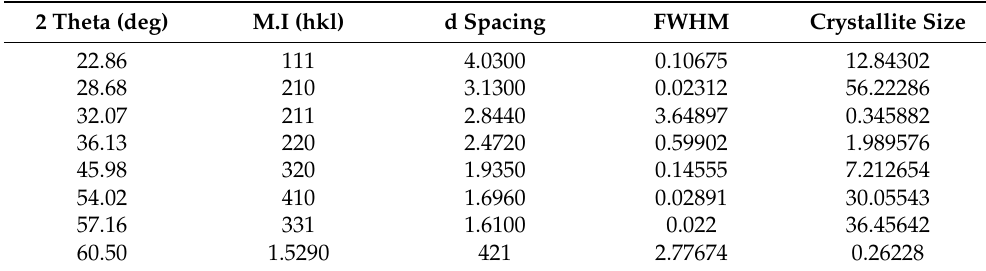
Table 2. XRD Diffraction Pattern of Mn